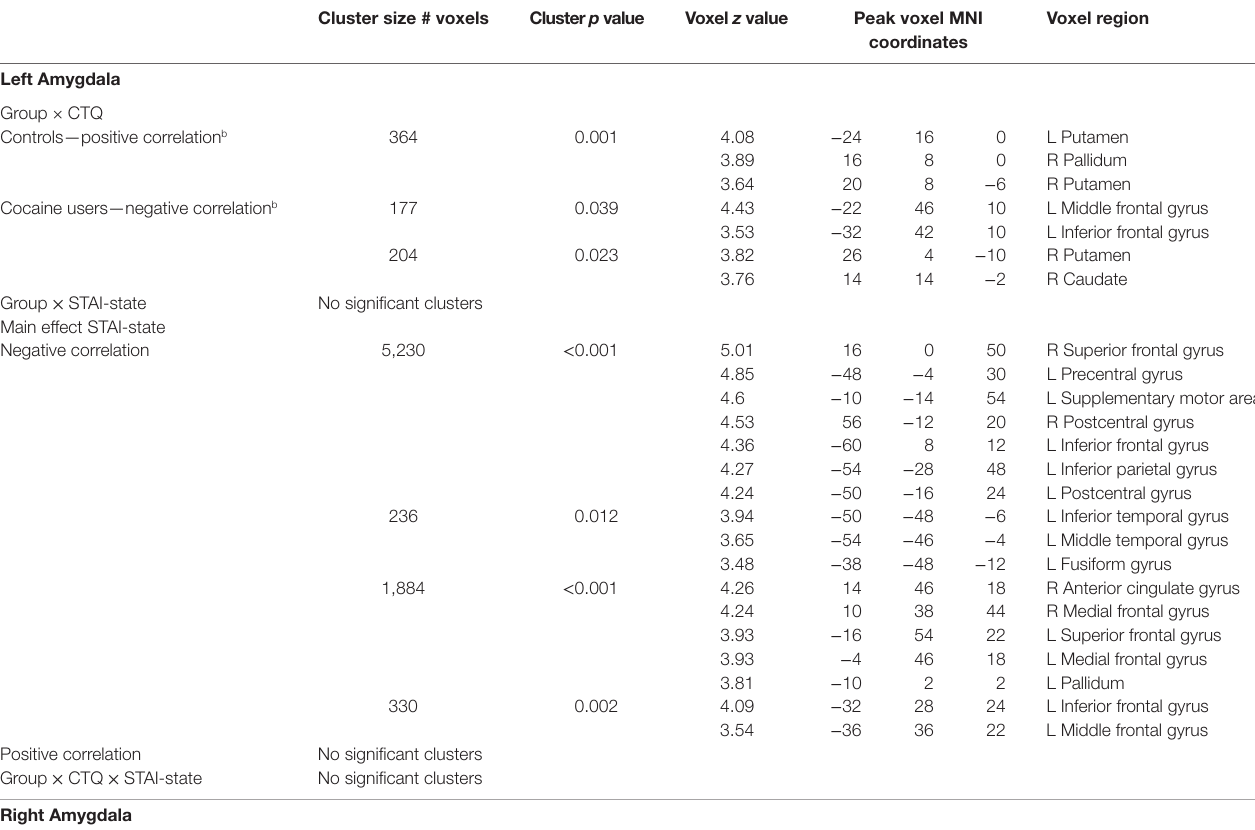
TaBle 4 | Differences in amygdala connectivity during cue reactivity (cocaine versus neutral) and the relation to childhood trauma (CTQ), STAI-state, and its